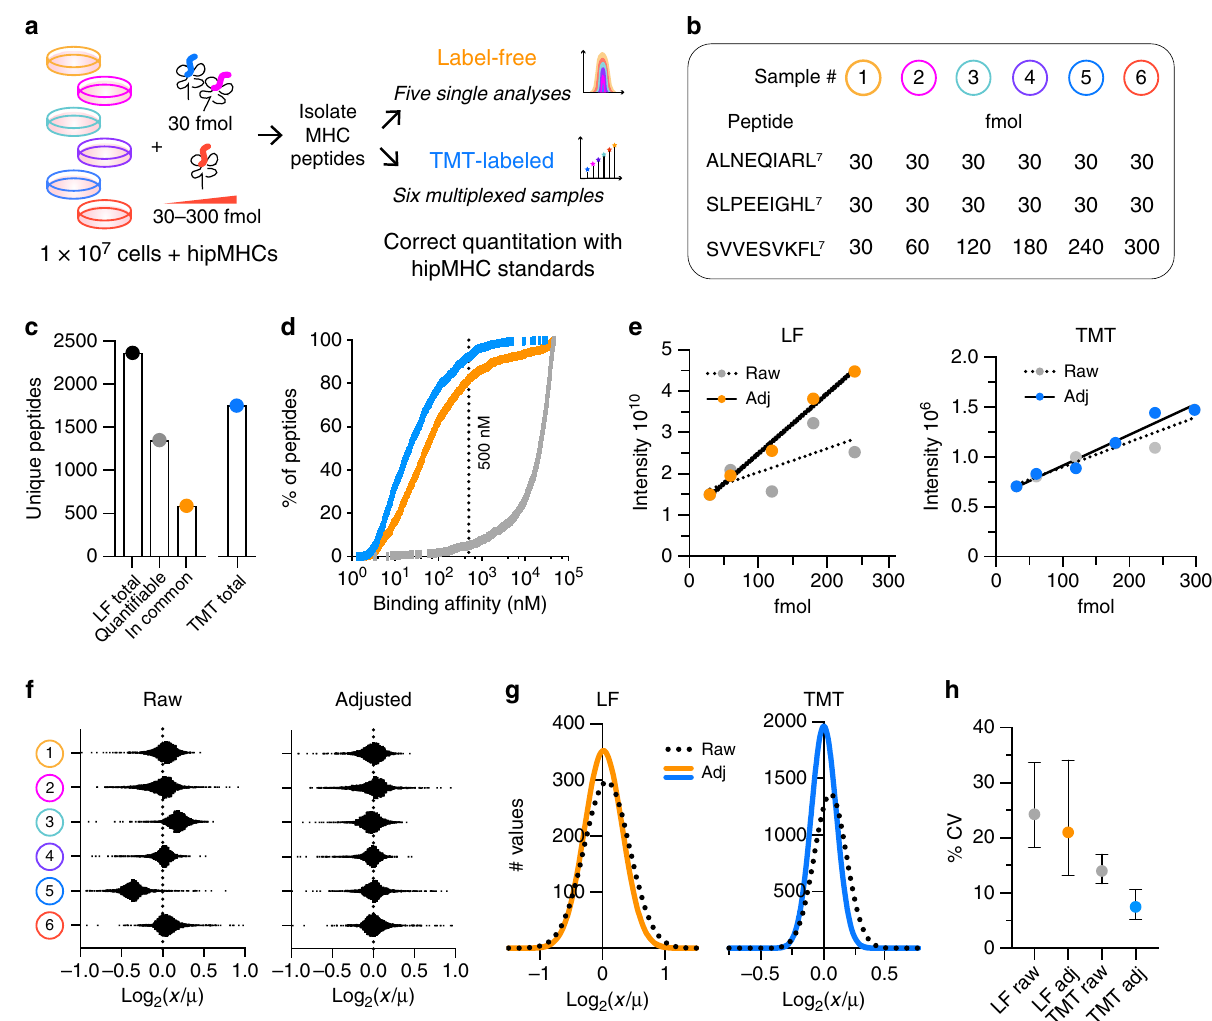
Fig. 2 HipMHCs improve quantitation in LF and TMT-labeled samples. a Experimental design. Five LF (orange) and six TMT (blue) technical replicates of 1 × 10 7 cells + hipMHCs were used to compare LF and TMT quanti fi cation. b Peptide sequence and amount of hipMHC added into each sample. L 7 denotes heavy-isotope-labeled leucine ( + 7). ALNEQIARL 7 and SLEEPIGHL 7 were used as quanti fi cation correction hipMHCs, and SVVESVKFL 7 was titrated in across samples. For LF analysis, sample #6 was omitted. c Two thousand three hundred and sixty-nine unique LF peptides were identi fi ed across fi ve analyses (black), 1352 of which were quanti fi able (gray) via AUC quanti fi cation, and 589 quanti fi able peptides which were identi fi ed in all fi ve analyses (orange). One thousand seven hundred and fi fty-four unique peptides were quanti fi ed with TMT-labeled analyses combining six TMT fractions (blue). d Ninety-two percent of TMT, 82% of LF, and 5.6% of random peptide 9-mers derived from the proteome (gray) are predicted to bind to an HLA allele in MDA-MB-231 cells with an af fi nity < 500 nM. e Linear fi t of titrated hipMHC peptide for LF (left) and TMT (right). Raw r 2 = 0.48 (LF) and r 2 = 0.91 (TMT), hipMHC-adjusted (adj) r 2 = 0.99 (LF) and r 2 = 0.96 (TMT). f Distribution of the log 2 fold change (FC) of each peptide ’ s quanti fi cation ( x ) over the mean ( μ ) peptide quanti fi cation across samples for raw (left) and hipMHC adjusted (right). g Gaussian fi t of the frequency distribution of log 2 (FC) of ( x ) over ( μ ) for raw and hipMHC-adjusted LF and TMT samples. In all, 99.7% of variance between peptide quantitation (3× SD) is captured within a 1.65 (raw) and 1.52 (adj) FC from the mean for LF samples, and 1.30 (raw) and 1.23 (adj.) for TMT samples. h Median coef fi cient of variation (CV) for LF (24.27% raw, 20.99% adj) and TMT (14.00% raw, 7.48% adj). Error bars represent the interquartile range. Source data are provided in the Source data fi